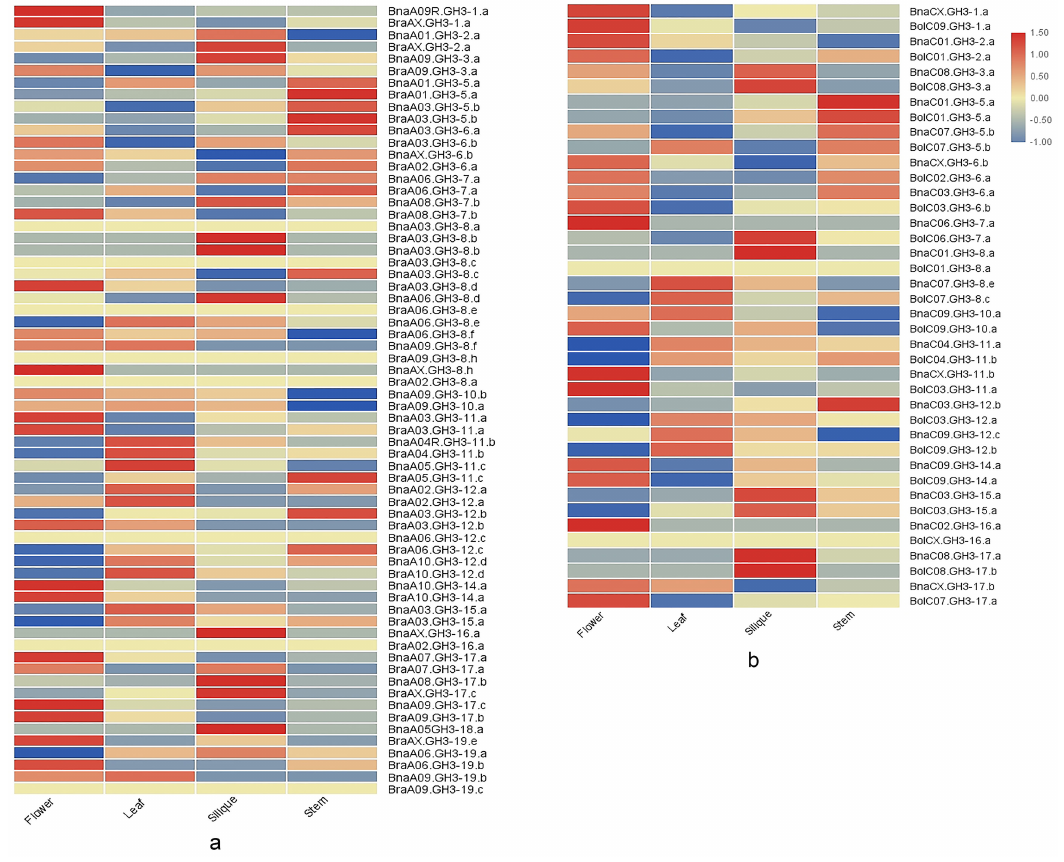
Figure 8. The comparison of expression patterns between orthologous pairs. ( a ) Thirty-three GH3 A n -A r orthologous pairs; ( b ) twenty GH3 C n -C o orthologous